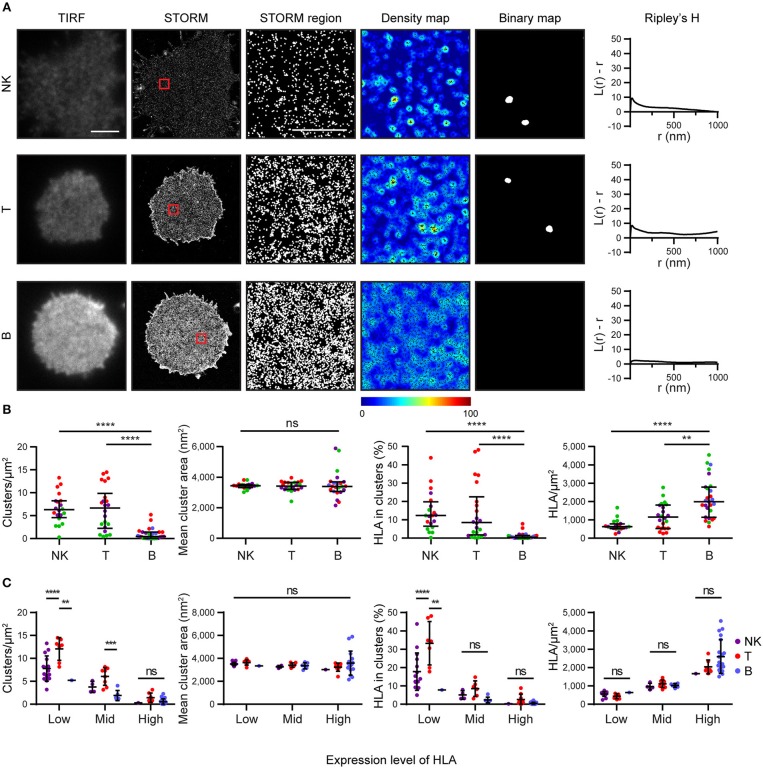
HLA on the surface on B cells is more homogeneous than on other lymphocytes. Lymphocytes isolated from peripheral blood by negative selection were stained for microscopy with mAb W6/32 that binds folded HLA-I. (A) Representative TIRF microscopy and STORM images of NK cells, T cells and B cells (scale bar: 3 μm). STORM panels show the Gaussian-rendered image of co-ordinate data. The 1 × 1 μm regions (red boxes in STORM images) are enlarged and the corresponding scatter plots, density maps (G&F analysis) and binary maps are shown (scale bar: 500 nm). The Ripley's H function is plotted for that cell. (B) Quantitative analysis of nanoclusters. Each dot represents the mean value for a cell and colors represent cells derived from different donors. Kruskal-Wallis test with Dunn's multiple comparisons. Black bars show median and interquartile range. (C) Lymphocytes were stratified into three groups (Low, Mid, High) according to the density of HLA-I in STORM images. Colors represent different cell types. Two way ANOVA with Tukey's multiple comparisons test. Black bars show mean and standard deviation. NK (20 cells; 3 donors); T (22 cells; 3 donors); B (27 cells; 4 donors) (Graphpad Prism version7); **p < 0.01, ***p < 0.001, ****p < 0.0001.